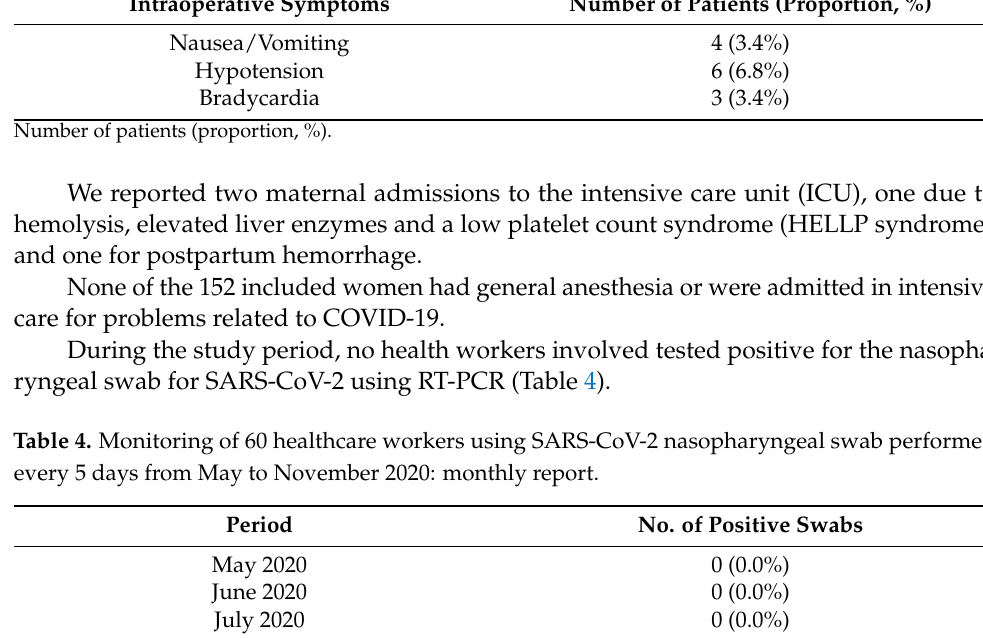
Table 3. Intraoperative symptoms in pregnant patients undergoing cesarean section. Intraoperative Symptoms Number of Patients (Proportion, %) Nausea/Vomiting 4 (3.4%) Hypotension 6 (6.8%) Bradycardia 3 (3.4%)